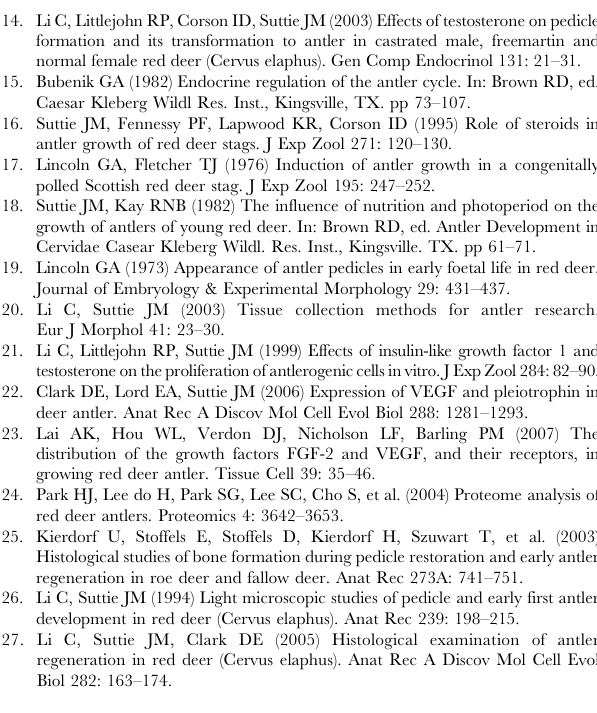
Figure S3 Merged networks of the PPC proteome. For detailed annotation of the figure, please refer to Figure S2 . (TIF) Table S1 Proteins expressed by AP cells indicating expression levels compared with FP cells. Proteins are grouped by cell function or cell location. ON= present in APCs but not FPCs. (DOCX) Table S2 Proteins expressed by PP cells indicating expression levels compared with FP cells. Proteins are grouped by cell function or cell location. ON= present in PPCs but not